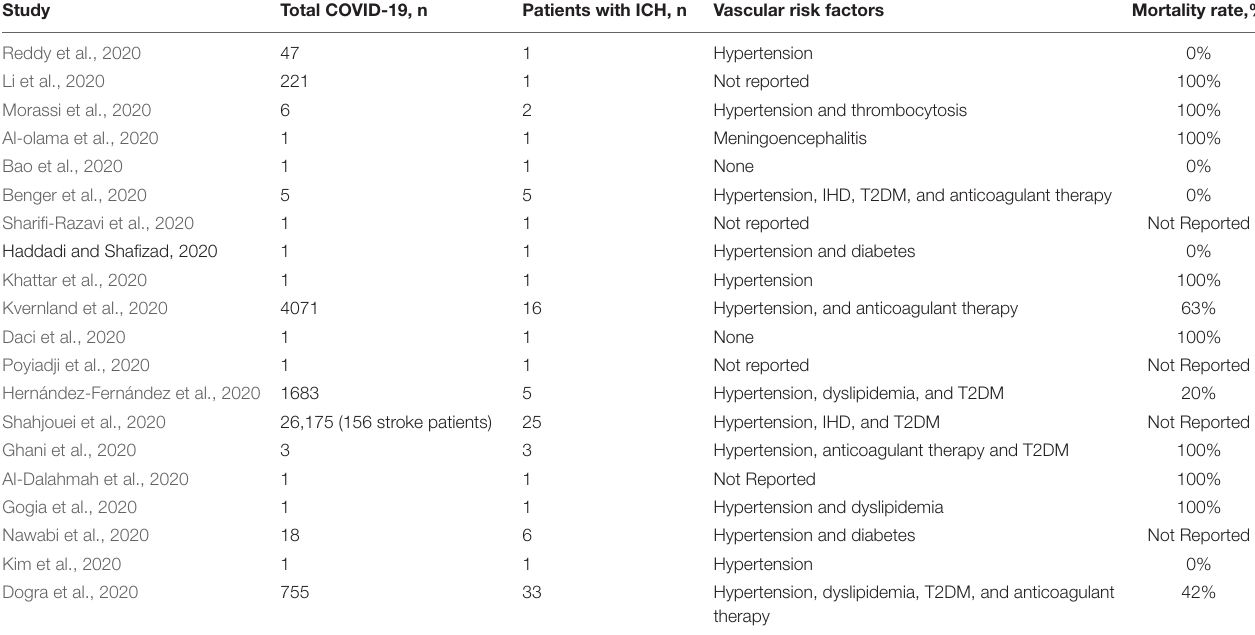
TABLE 1 | Summary of published cases of COVID-19-related